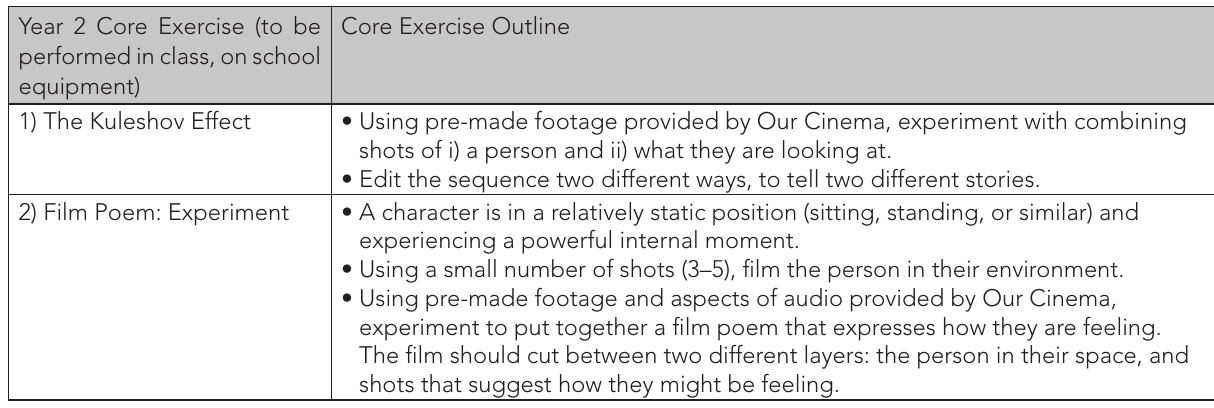
Table 1b. Year 2 – Between Two Shots Across Year 2, the expectation is that a more simplified approach to camera perspective will be adopted in order to allow more scope for editing. Like the films of Bill Douglas, all camera shots should thus be static and on a